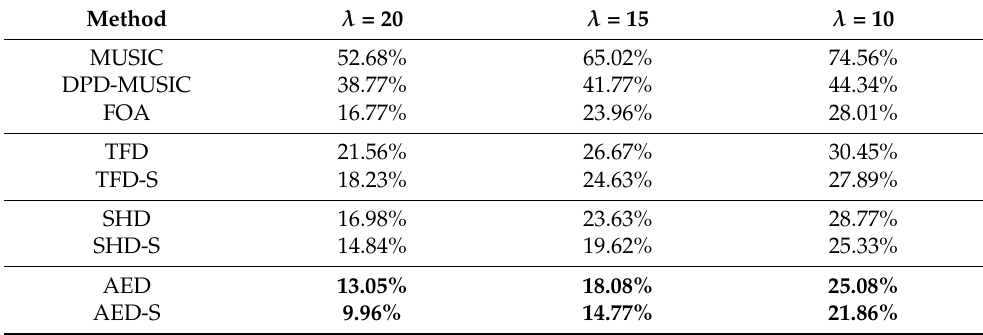
Table 3. GE for the azimuth